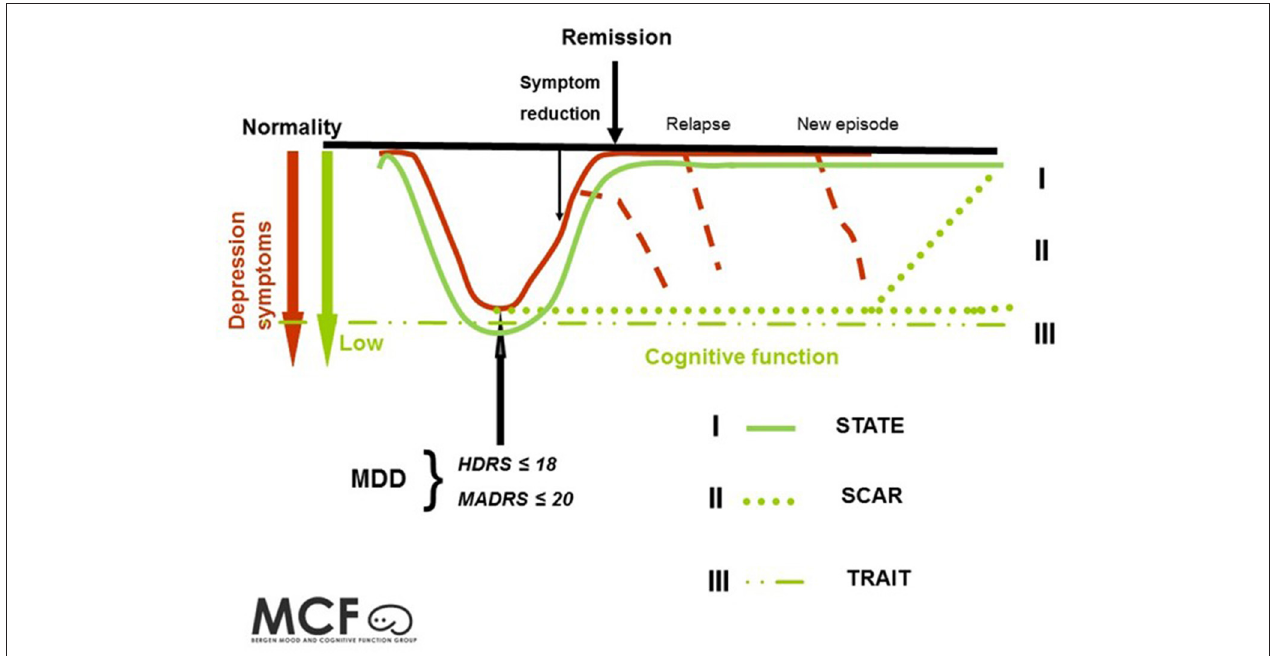
FIGURE 1 | Illustrates three hypotheses regarding the neurocognitive profile in depression. (I) The state hypothesis: cognitive impairment is state dependent and follows mood symptoms. See "I". (II) The scar hypothesis: cognitive impairment is a result of a scarring effect from the neurotoxic effects of depression. See "II". (III) The trait hypothesis: cognitive impairment is related to stable persistent features. See "III". This figure is adapted from Hammar and Årdal ( 2) and Frank et al.